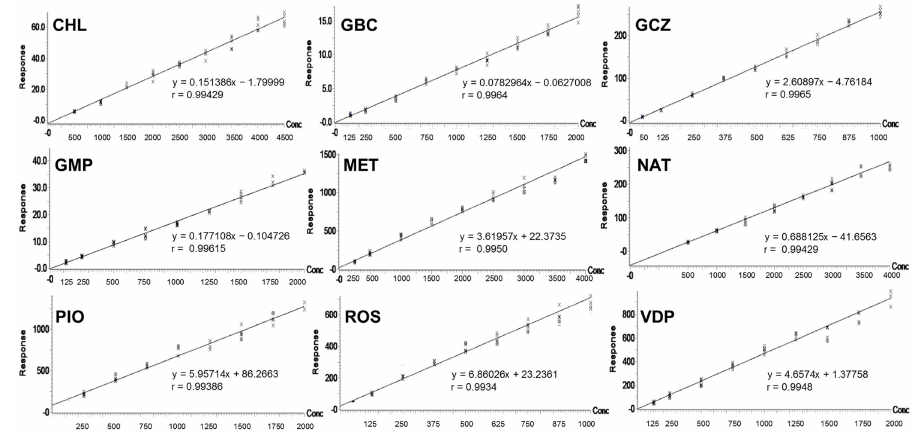
Fig 4. Calibration curve of analytes in plasma